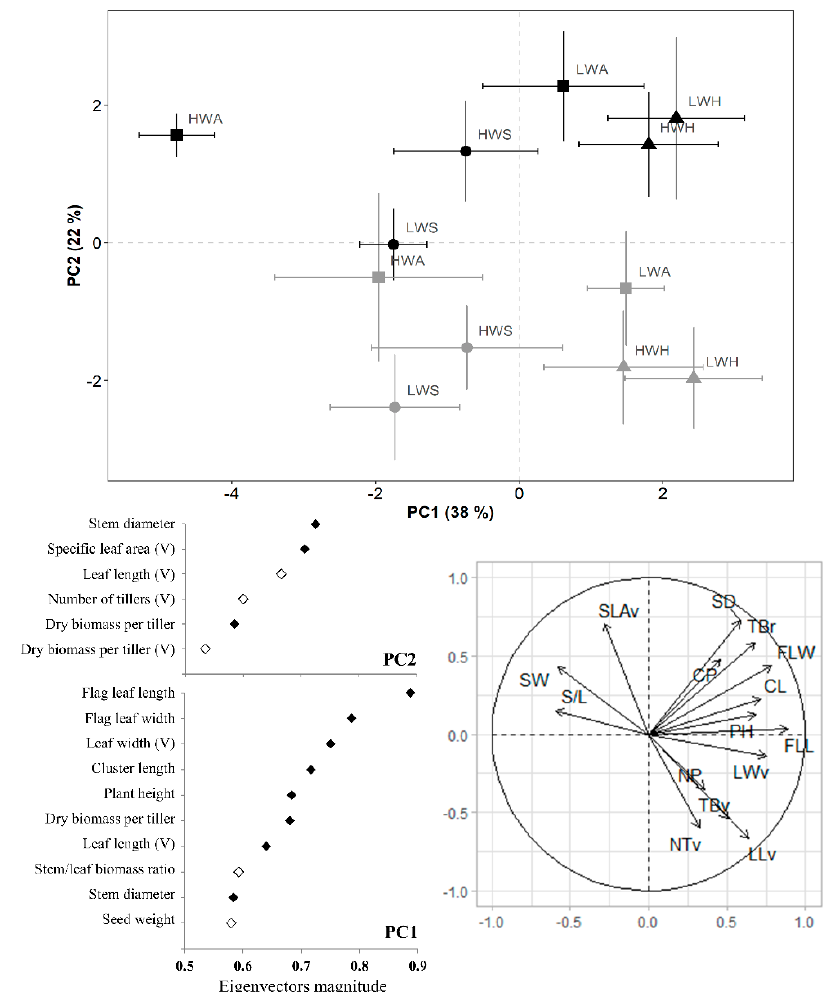
Figure 3. Principal Component Analysis (PCA) of plant functional traits in populations of Leptochloa crinita cultivated in two experimental environments: Sumalao (grey symbols) and Esperanza (black symbols) during the 2014–2015 summer season. The ID of populations is composed of seed weight (high/low) and origin of population. HWA: high weight-arid origin. HWH: high weight-humid origin. HWS: high weight-saline origin LWA: low weight-arid origin. LWH: low weight-humid origin. LWS: low weight-saline origin. PH: Plant height. NP: Number of panicles. S/L: Stem/leaf biomass ratio. TBr: tiller biomass at the reproductive stage. SW: Seed weight. FLL: Flag leaf length. FLW: Flag leaf width. CP: Number of clusters per panicle. CL: Cluster length. NTv: Number of vegetative tillers. TBv: tiller biomass at the vegetative stage. LLv: Leaf length. LWv: Leaf width. SLAv: Specific leaf area.